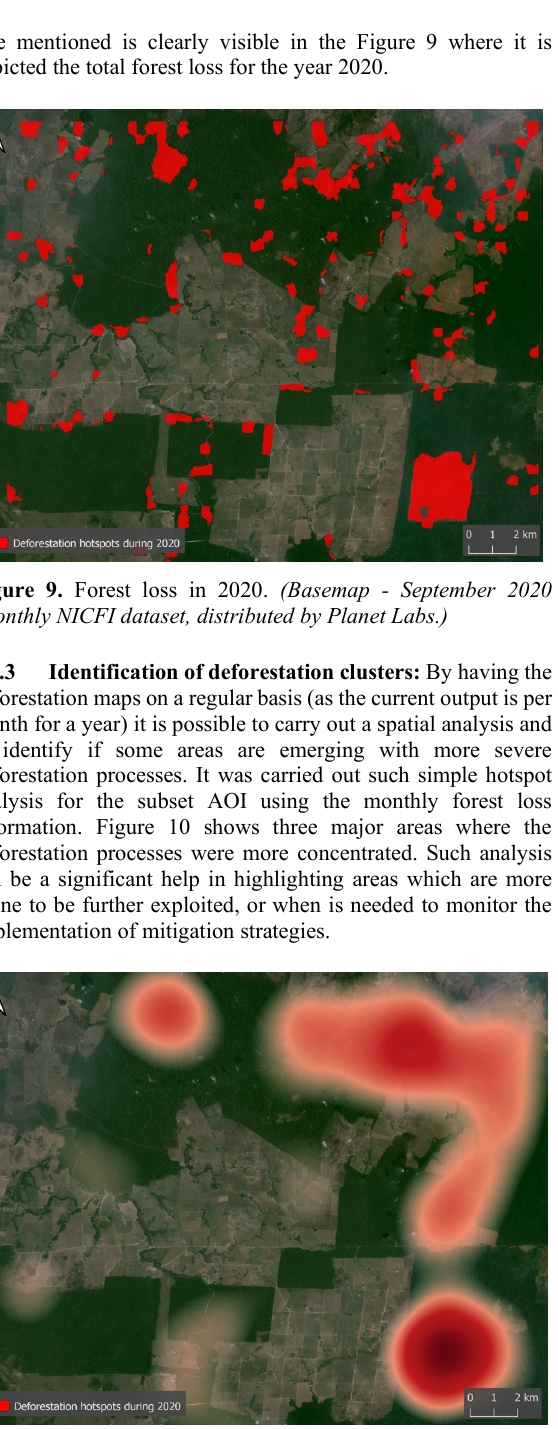
Figure 10. Deforestation hotspots. (Basemap - September 2020 monthly NICFI dataset, distributed by Planet Labs.)